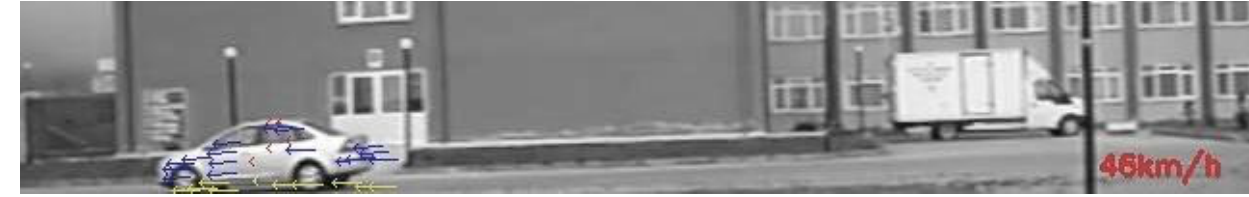
Figure 1. Velocity vectors before filtering of